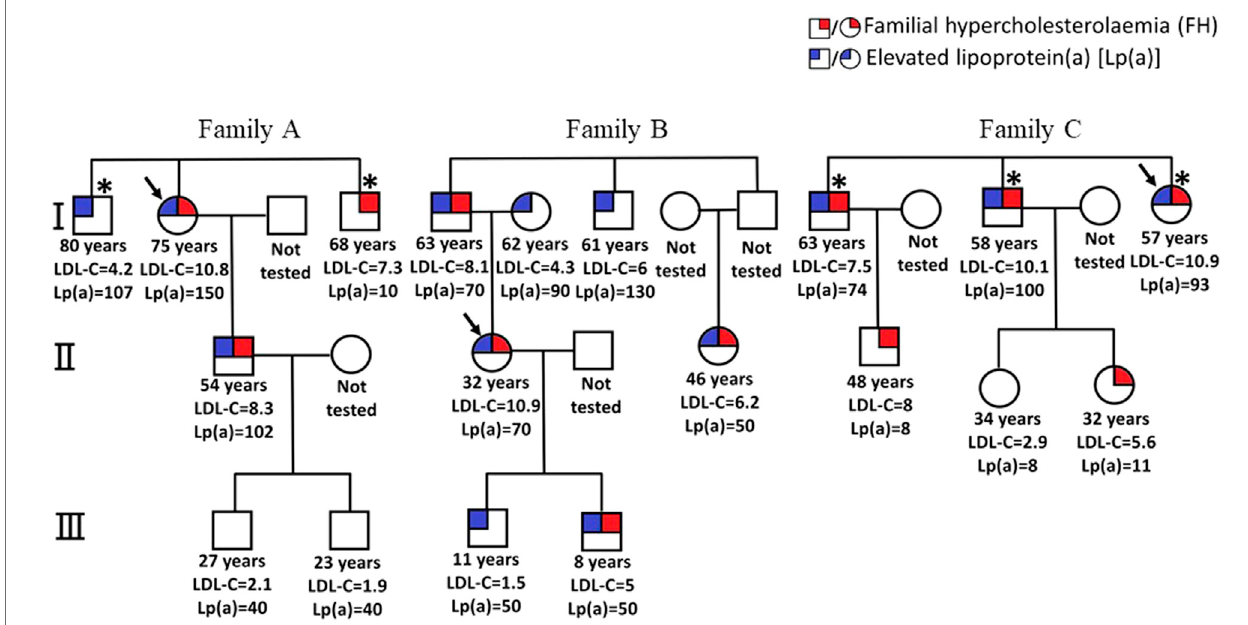
FIGURE 4 | Pedigrees of families (A – C) with familial hypercholesterolemia (FH) and elevated lipoprotein (a) [Lp(a)] ≥ 50 mg/dL, with their LDL cholesterol concentrations (mmol/L) and Lp(a) concentrations (mg/dl). In families (A,C), two new cases of FH and elevated Lp(a) were identi fi ed among fi ve relatives tested. In family (B),allsixrelativestestedwerefoundtohaveelevatedLp(a)(i.e.,onenewcaseofelevatedLp(a)foreveryrelativetested)andthreeidenti fi edwithFH.However,therewere familieswhere fewer,or norelatives weredetectedthan thoseshown inthesethree families. Asterisk* indicates coronary artery disease. From Chakraborty Aet al. Cascadetesting forelevatedlipoprotein(a) inrelativesofprobandswithfamilialhypercholesterolemiaandelevated lipoprotein(a).Atherosclerosis 2021,withpermission.